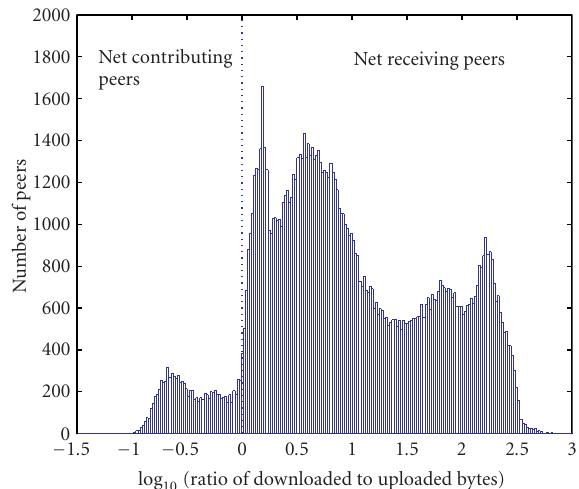
Figure 1: Histogram of the logarithm of the ratio of bytes sent to bytes